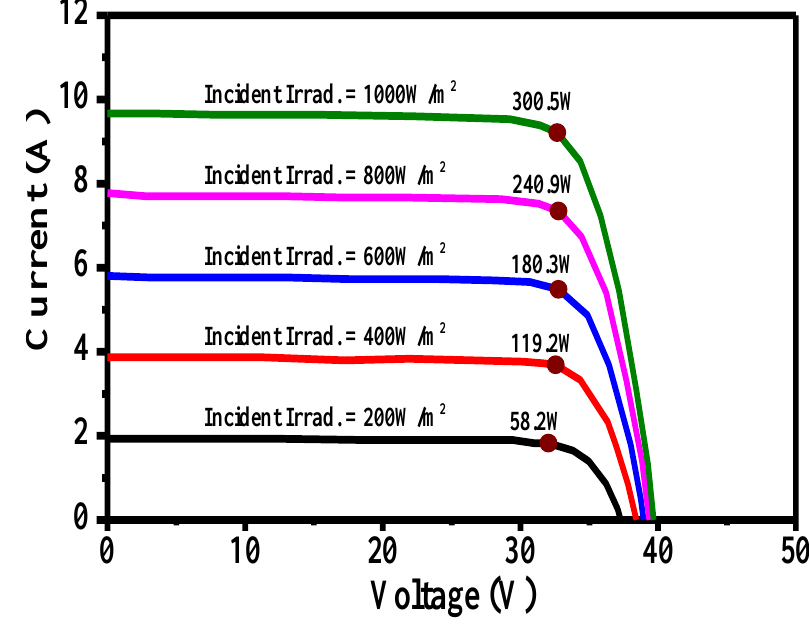
Figure 2: IV characteristics at various irradiance densities for PV panel used in the simulation.